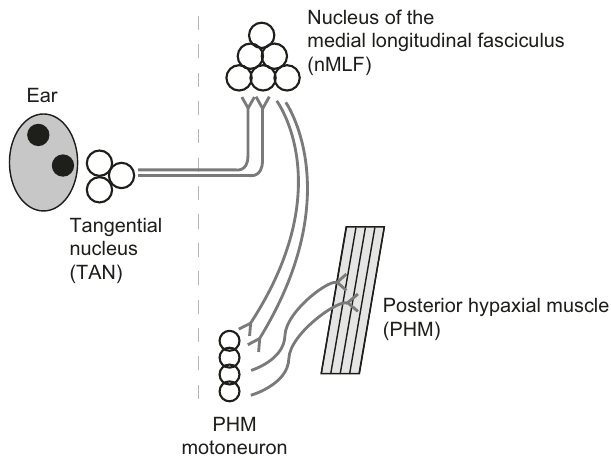
Fig. 3 | A hypothesis of the neuronal circuits that produce the VBR. Vestibular inputs activate neurons in the tangential nucleus (TAN). TAN neurons project to neurons in the nucleus of the medial longitudinal fasciculus (nMLF) on the con- tralateral side. The axons of the nMLF neurons descend to the spinal cord and project to motoneurons thatinnervate posterior hypaxial muscles (PHMs). Rostral is toward the top. The dashed line shows the